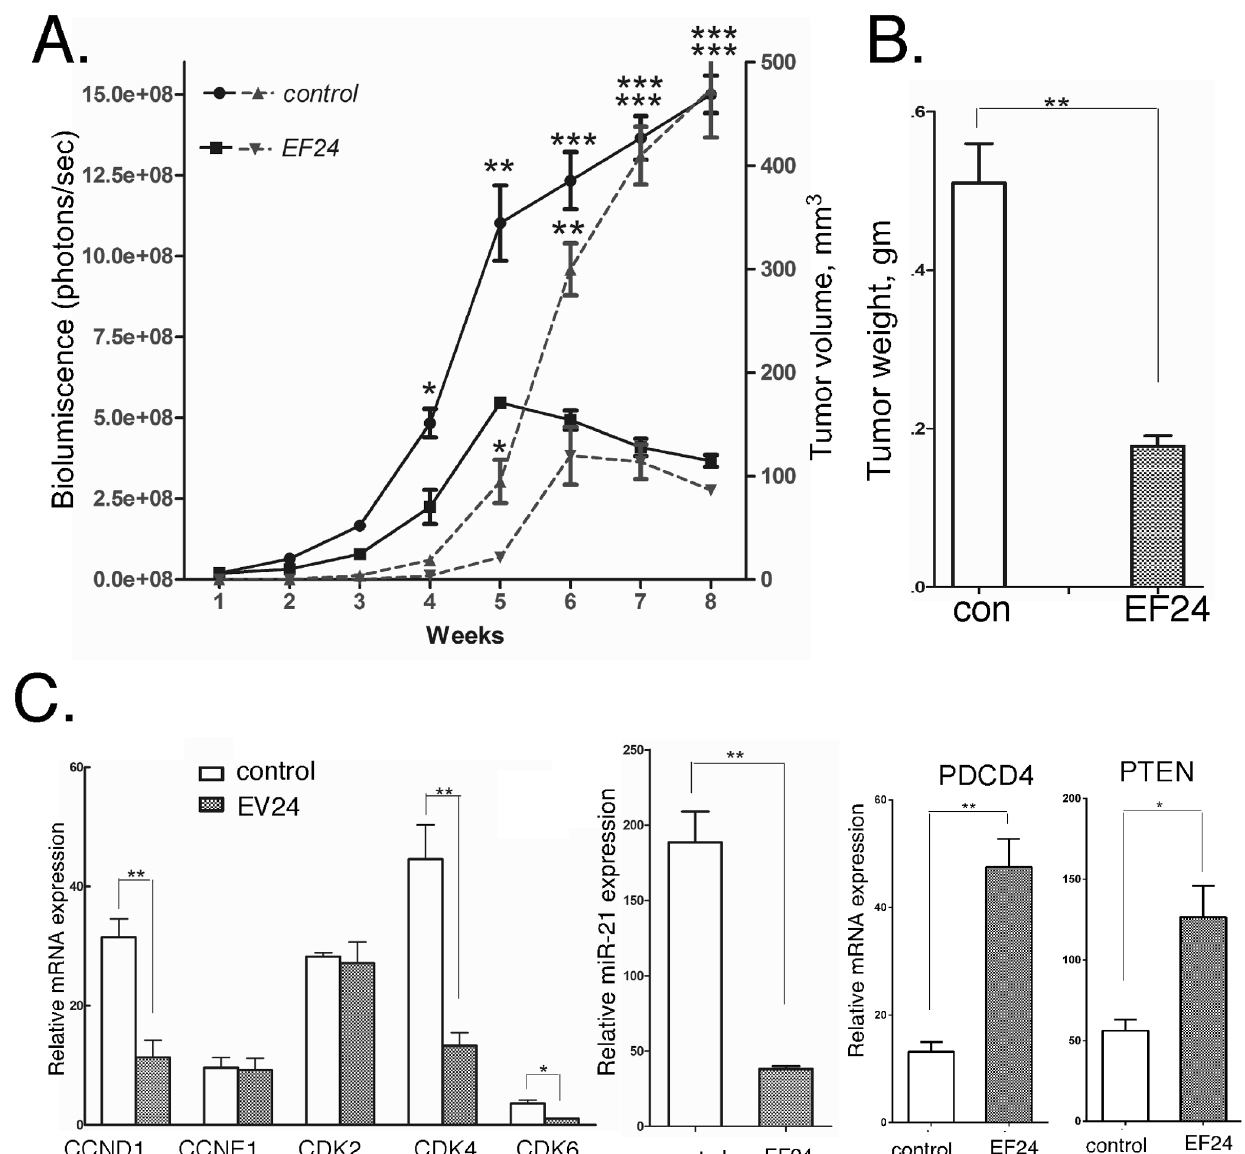
Figure 6. EF24 inhibits prostate cancer tumor xenograft growth invivo . (A,B) NSG mice were injected subcutaneously with 10 6 DU145 cells, and after tumor engraftment mice were injected daily with EF24 (200 m g/kg body weight). (A) Tumor growth was determined by bioluminescent imaging of mice injected with luciferin (solid line) or by caliper measurements (dashed line) (n=8). (B) At necropsy tumors were weighed, or (C) RNA was extracted from tumor tissue and subjected to gene expression analysis by qPCR as indicated (n=3).